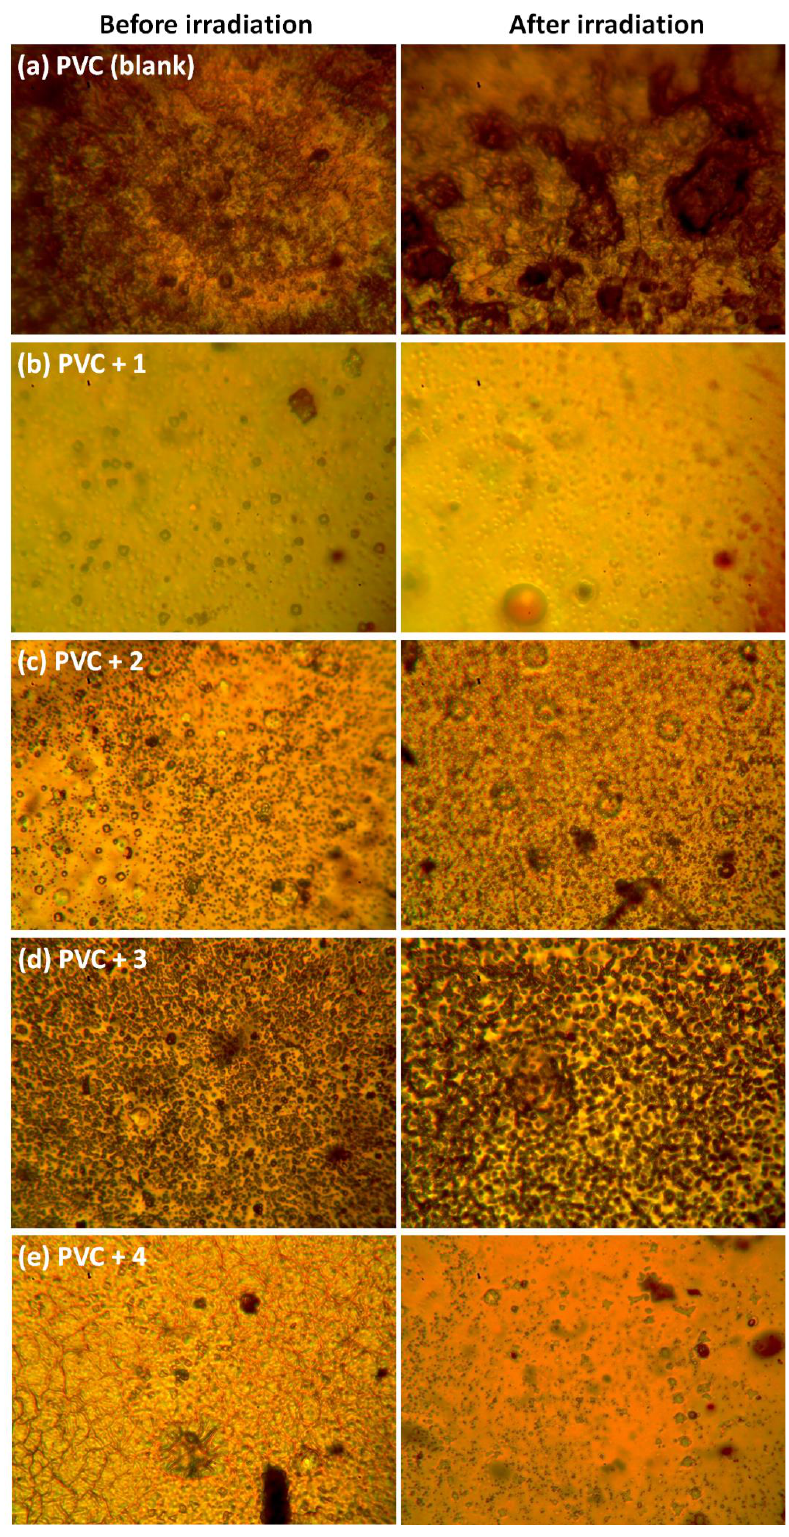
Figure 6. Optical images for PVC films (left) before and (right) after irradiation (300 h) at 400× magnification: ( a ) PVC (blank), ( b ) PVC + 1 , ( c ) PVC + 2 , ( d ) PVC + 3 , and ( e ) PVC + 4 .